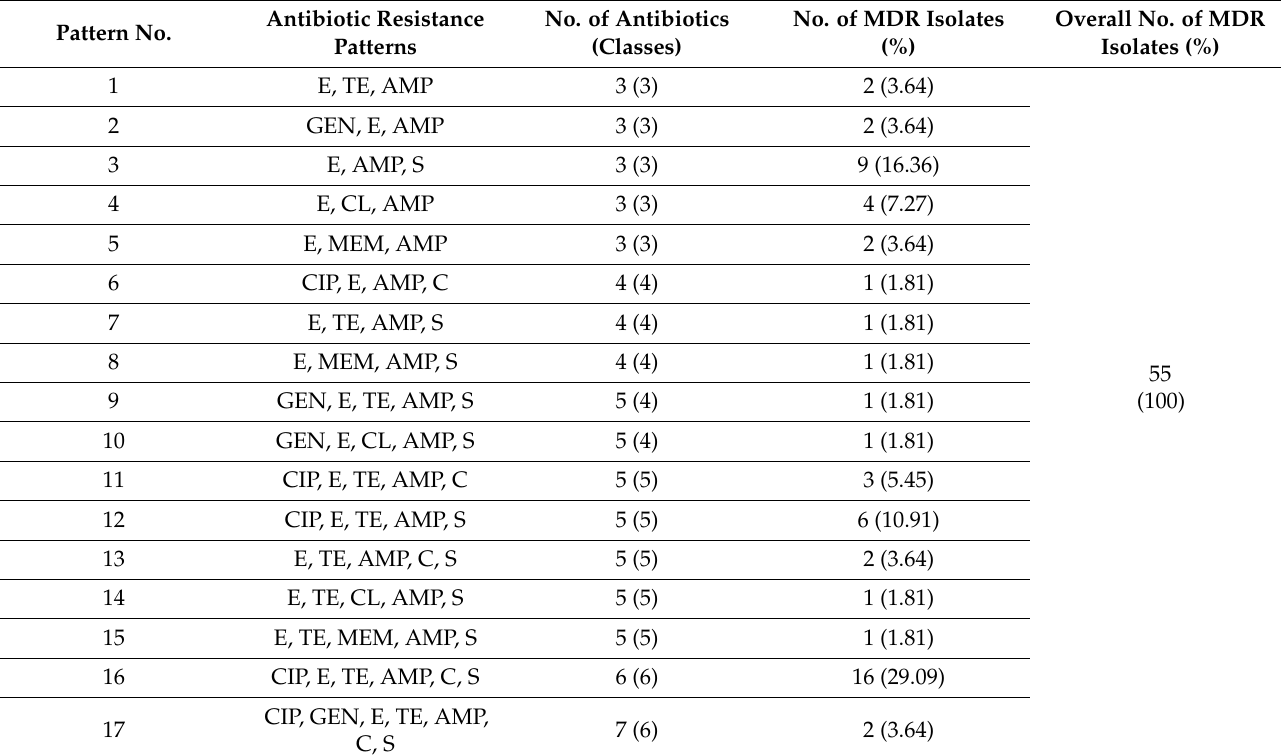
Table 4. Phenotypic resistance patterns of multidrug-resistant (MDR) E. coli isolated from fecal matter of migratory birds. Pattern